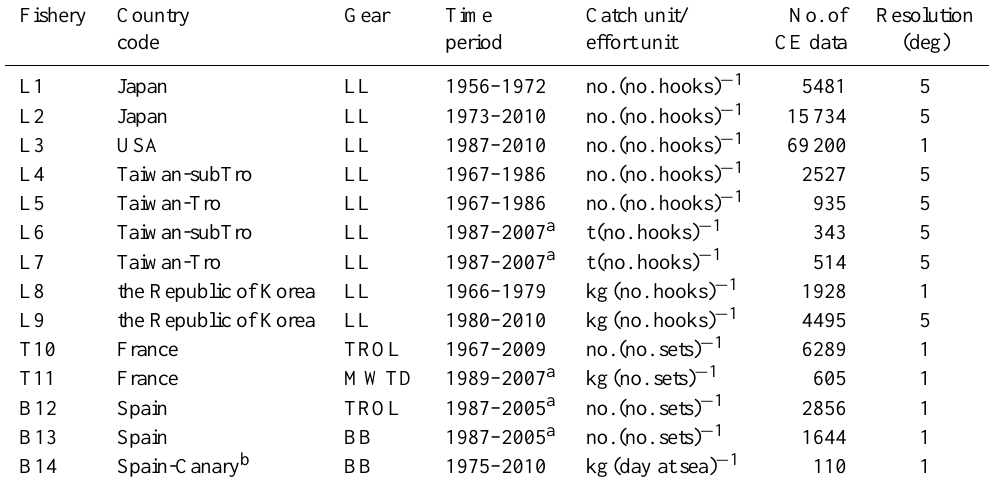
Table 2. Revised definition of fisheries for the North Atlantic albacore ( E : effort; C : catch) to be used for SEAPODYM application. LL: longline; TROL: trolling; MWTD: mid-water trawling; BB: baitboat pole and line; Tro: tropical; subTro: subtropical; t: metric tonnes.